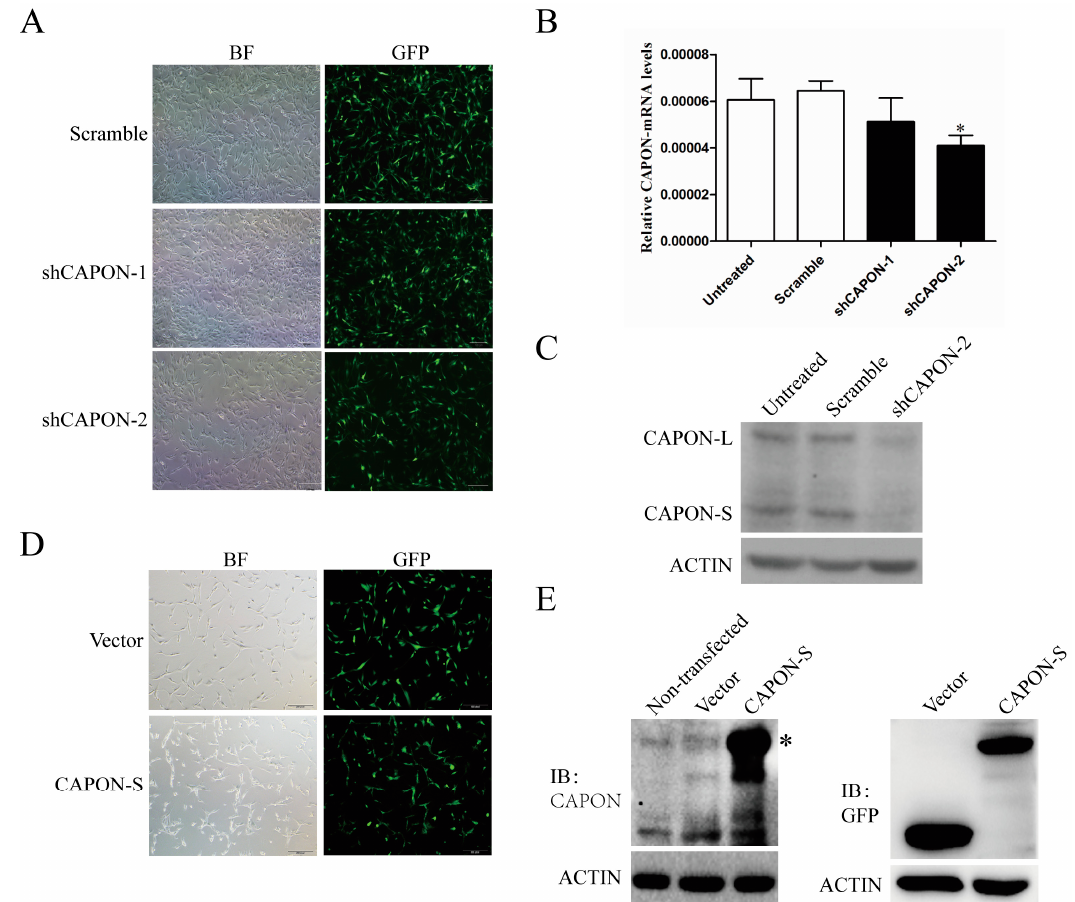
Figure 2. Identification of the efficiency of CAPON down-regulation and CAPON-S up-regulation in glioma cells. ( A ) The lentivirus infection efficiency was indicated by bright field (BF) and GFP fluorescence in scramble and shCAPON groups (Magnification ×100); ( B ) qRT-PCR analysis of the CAPON down-regulation efficiency at mRNA levels (* p < 0.05); ( C ) Western blot analysis of the down-regulation efficiency of shCAPON-2 at protein levels; ( D ) The lentivirus infection efficiency was indicated by bright field (BF) and GFP fluorescence in Vector group and CAPON-S group (Magnification ×100); ( E ) Western blot showed the overexpression efficiency of CAPON-S as detected by both CAPON and GFP antibodies. * indicate the overlap between CAPON-L and GFP-CAPON-S bands.